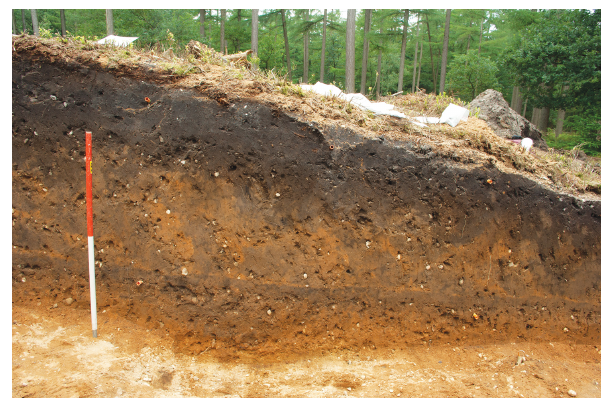
Figure 3. Soil record of a barrow showing a paleosol buried by a barrow, built with sods, dug in heathlands in the surroundings. Photograph by Q.